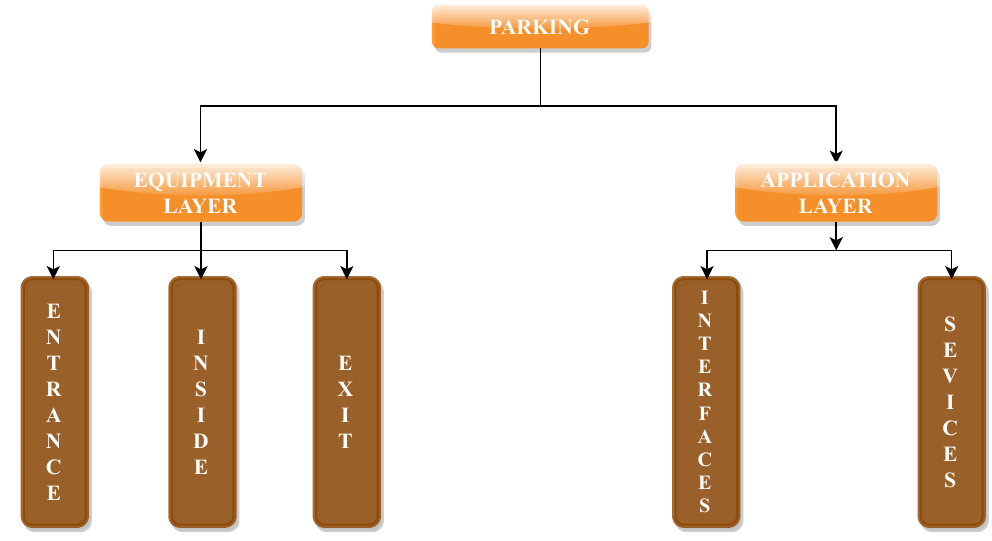
Figure 7. The simplified Layers of our